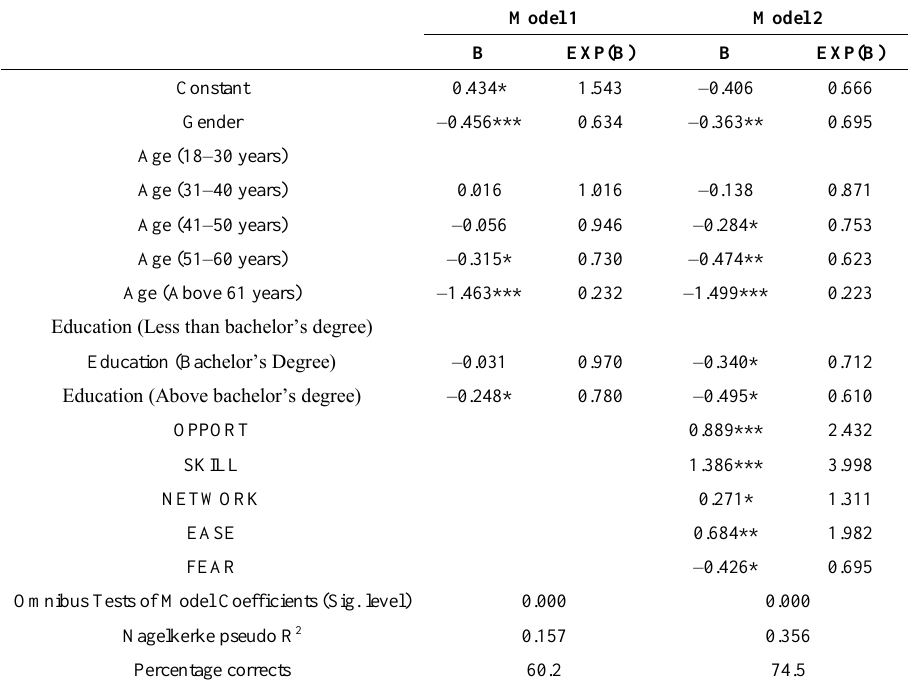
Table 6. Logistic Regression for Entrepreneurial